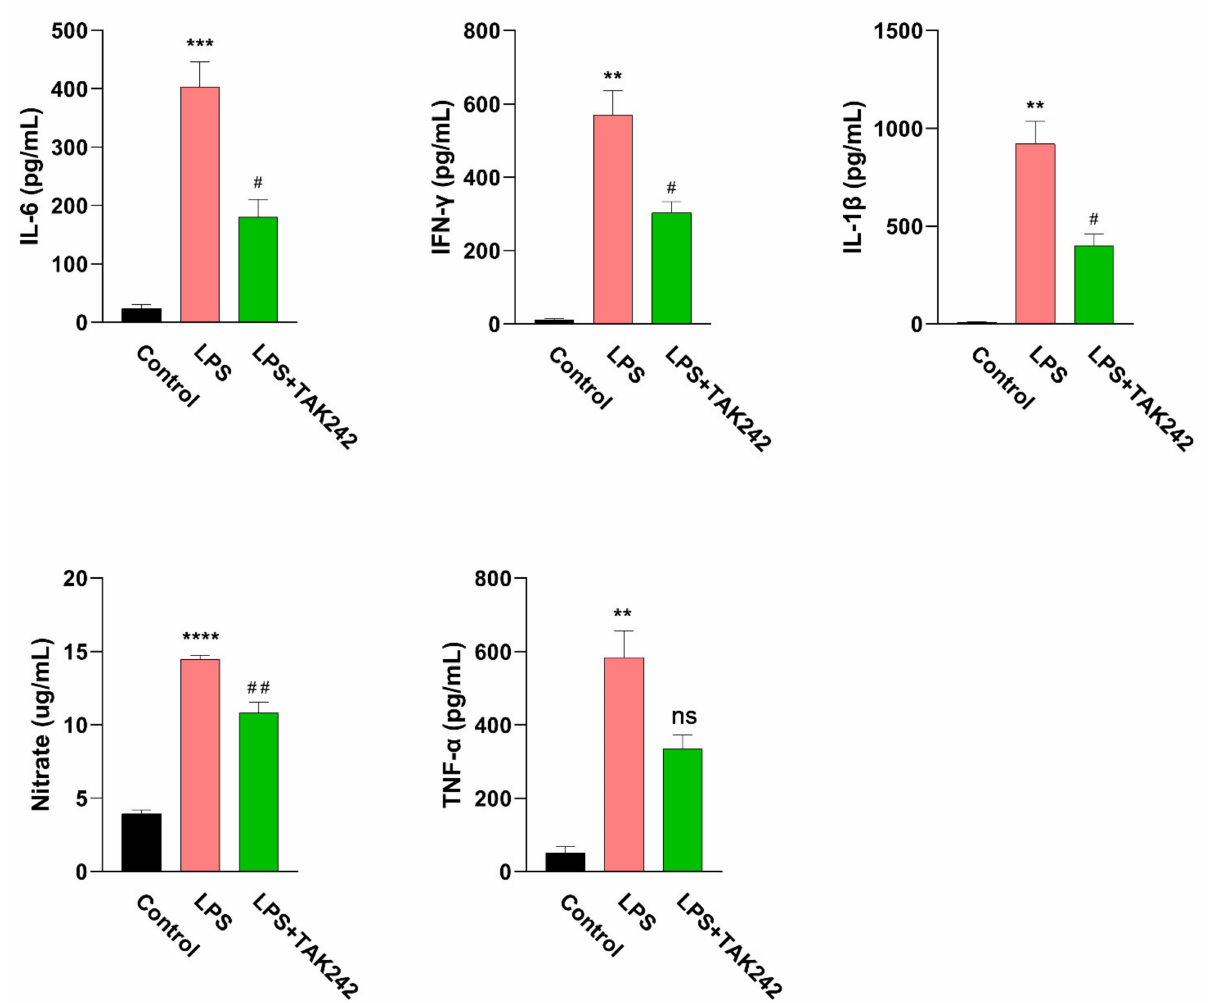
Figure 2. The changes of cytokine levels in LPS-induced peritonitis mice. C57BL/6 mice were injected with LPS (10 mg/kg, i.p.) with or without TAK 242 (5 mg/kg, i.p.). Six hours later, saline (2 mL/mouse) was injected intraperitoneally into the abdominal cavity of the mouse before the mouse was sacrificed. Then, peritoneal lavage fluids were collected and subjected to ELISA assay for a series of cytokines including IL-6, IFN- γ , IL-1 β , Nitric oxide, and TNF- α . The results were demonstrated as means ± S.E.M. *, significantly different from the control group; ** p < 0.01; *** p < 0.001; **** p < 0.0001. #, significantly different from the LPS group; #, p < 0.05; ##, p < 0.01; and ns, no significance. Statistical significance interpretation was carried out by using the t -test approach. The data were demonstrated as the means ± S.E.M. Statistical significance interpretation was carried out using the one-way ANOVA followed by the Tukey post hoc